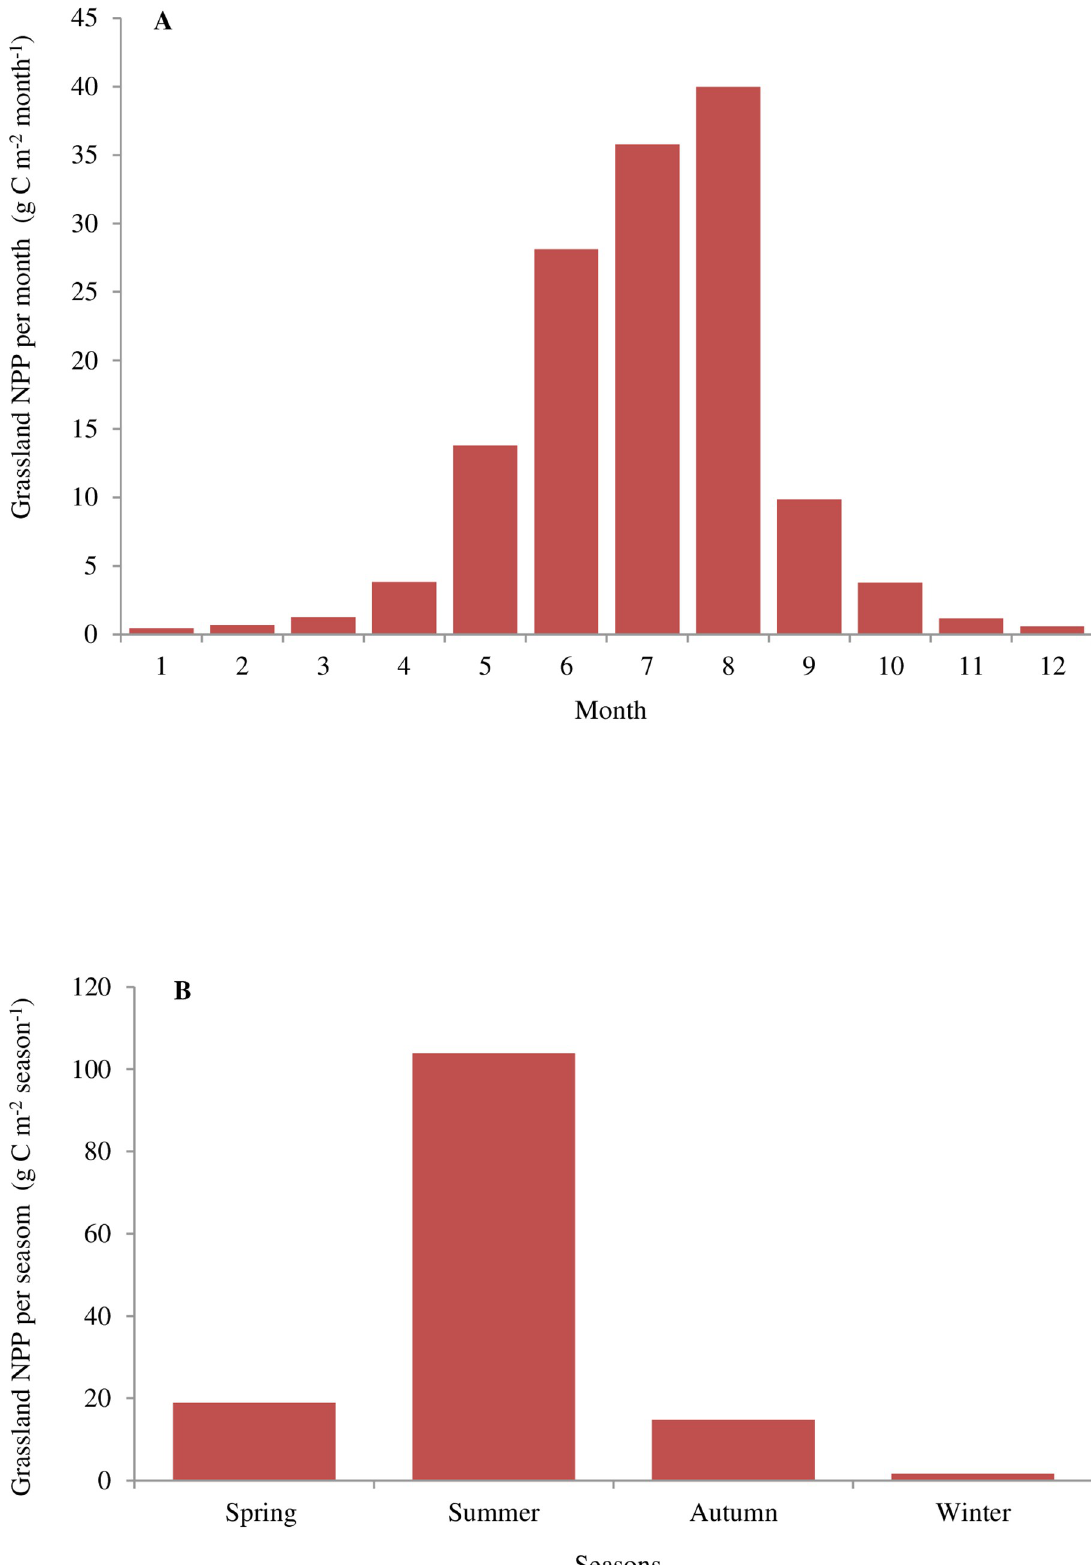
Fig 6. Monthly and seasonal variation of grassland NPP in Gansu, China from 1982 to 2011. https://doi.org/10.1371/journal.pone.0242609.g006 PLOS ONE | https://doi.org/10.1371/journal.pone.0242609 November23,